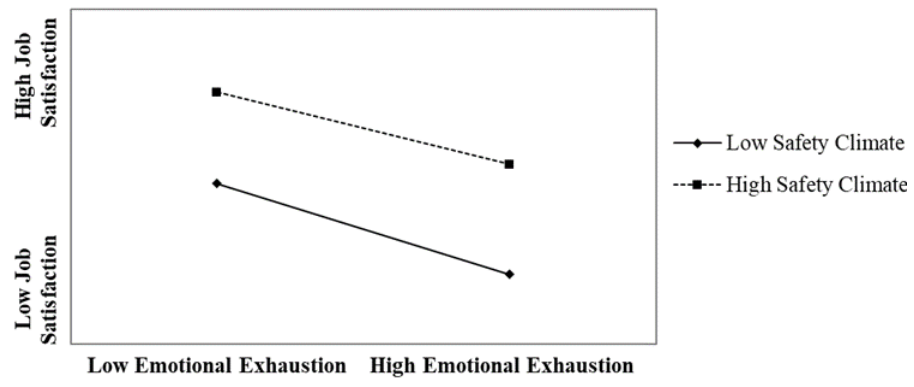
Figure 2. The moderating effect of the safety climate on the relationship between emotional exhaus- tion and job satisfaction.